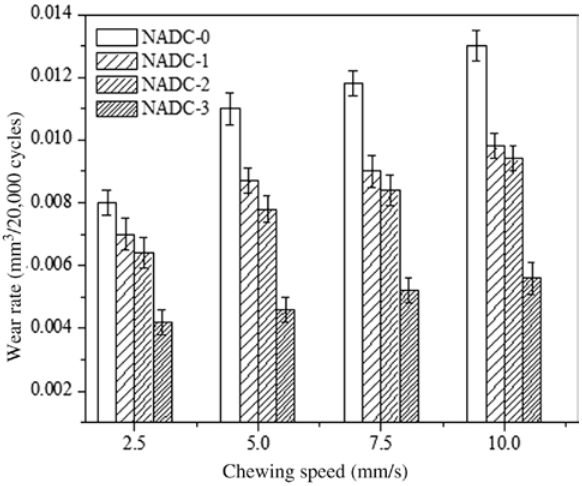
Figure 6: Effect of chewing speed on volumetric wear rate of the dental composites in distilled water condition (at constant normal load of 40 N and chamber temperature of 25 °